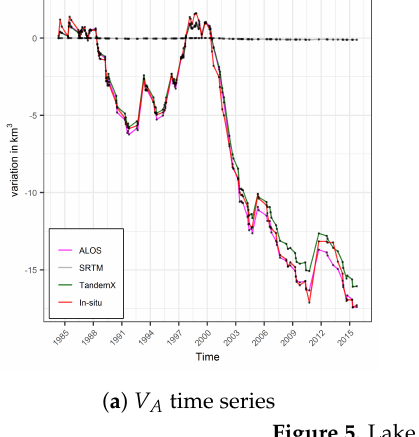
Figure 5. Lake Mead volume variations.